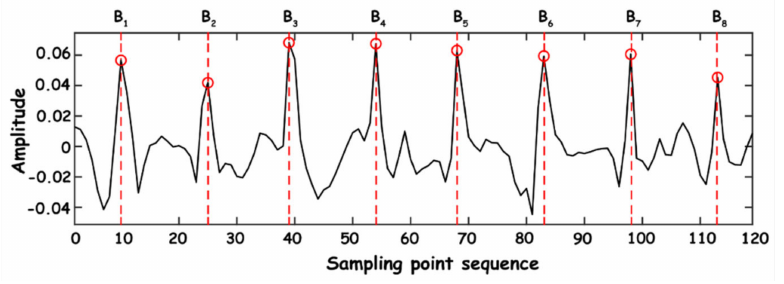
Figure 13. Time point